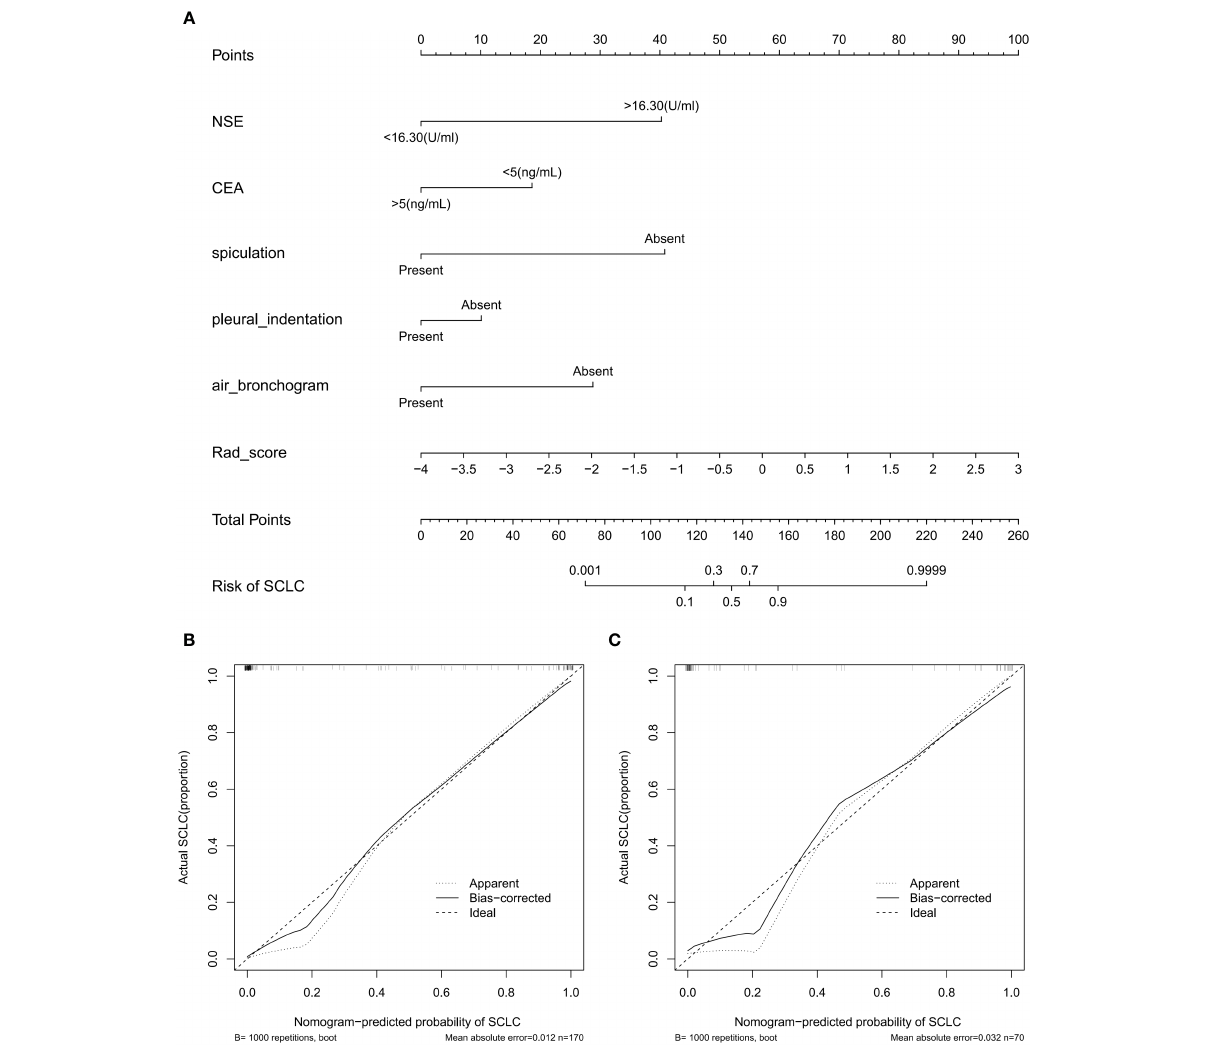
FIGURE 5 Radiomics-based nomogram (A) was developed in the training set, including the rad-score, NSE level, CEA level, spiculation, pleural indentation, and air bronchogram. Calibration curve of the nomogram in the training (B) and validation (C)